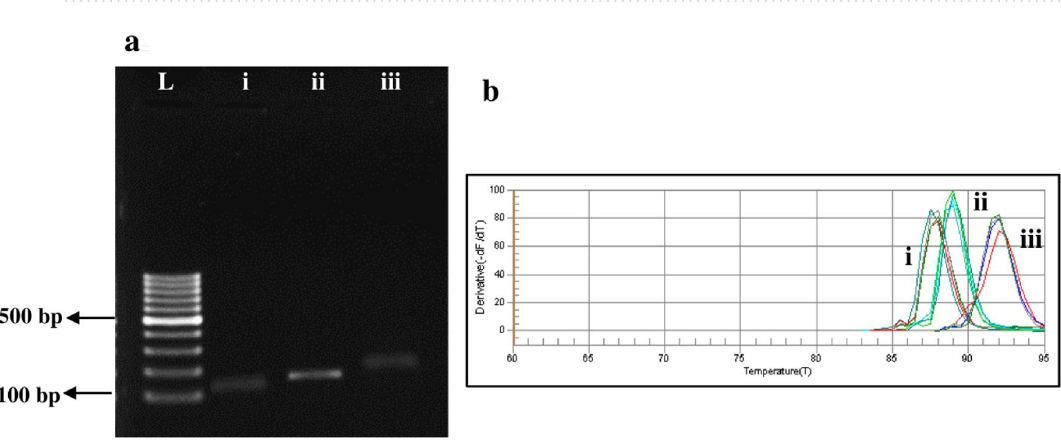
Figure 8. Specificity of the designed primers; a. A 2% agarose gel electrophoresis for detection of qseB, qseC, and 16S rRNA . L ladder 100 bp, i: qseB , ii: qseC , iii: 16S rRNA . b. Melting curve, i: qseB , ii: qseC , iii: 16S rRNA